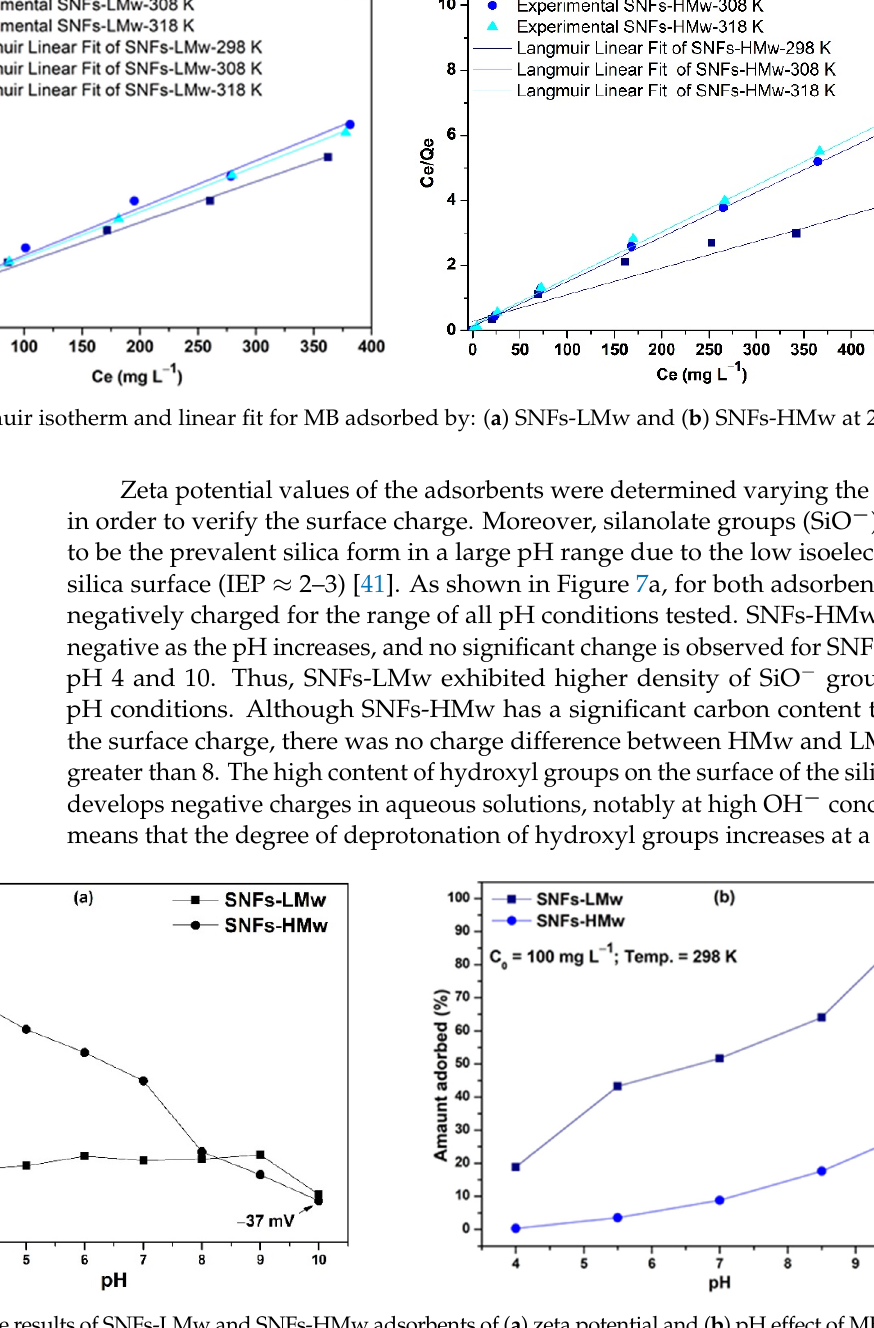
Figure 8. FTIR spectra before and after MB adsorption for ( a ) SNFs-LMw and ( b ) SNFs-HMw. The adsorption of MB on both SNFs was evaluated at different time intervals in the range of 15 to 480 min (Figure 9). As can be seen, approximately 65% of the MB adsorbed occurred in the first 15 min for SNFs-LMw. The rapid uptake could be due to an initial adsorption occurring on the external surface and on the larger mesopores of the adsor- bent. For SNFs-HMw which have only a small fraction of mesopores, only 37% of MB was adsorbed at the first 15 min. Consequently, adsorption was relatively slow as the dye mol- ecules diffused into the smaller pores. The adsorption equilibrium was achieved after 360 min for SNFs-LMw, which reached ~96% of MB removal. Adsorption equilibrium for SNFs-HMw occurred after 240 min with only ~65% of MB removal.